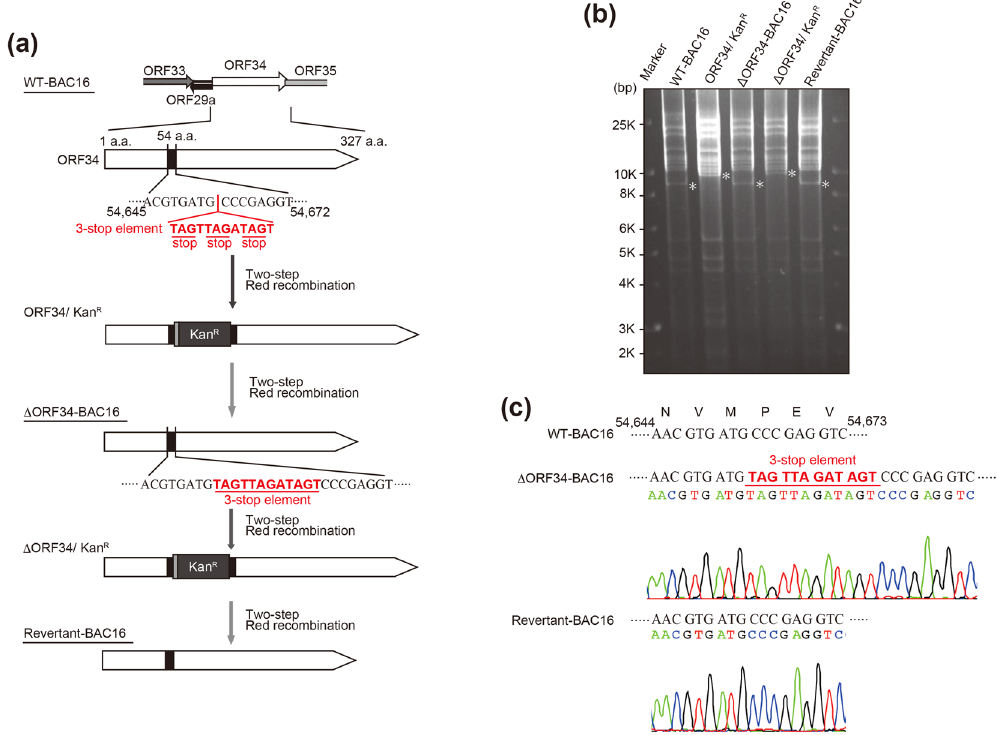
Figure 1. Construction of recombinant Δ ORF34 KSHV BAC and its revertant. ( a ) Schematic illustration of the KSHV genome including the ORF34 coding region. Using a two-step Red recombination system, three stop codons were inserted into the ORF34 coding region of KSHV BAC16 (nt54653 – nt54654; Accession number: GQ994935) to construct ORF34-deficient BAC clone ( Δ ORF34-BAC16). The stop codons were replaced with the original wild-type sequence for revertant BAC clone (Revertant-BAC16). ( b ) Agarose-gel electrophoresis of the recombinant KSHV BACmids, digested with EcoRI. The asterisks ( * ) indicate Insertion and deletion of a kanamycin-resistance cassette in each BAC clone. Original data is shown in Supplementary Fig. S1. ( c ) DNA sequencing results of ORF34 mutagenesis sites in Δ ORF34-BAC16 and